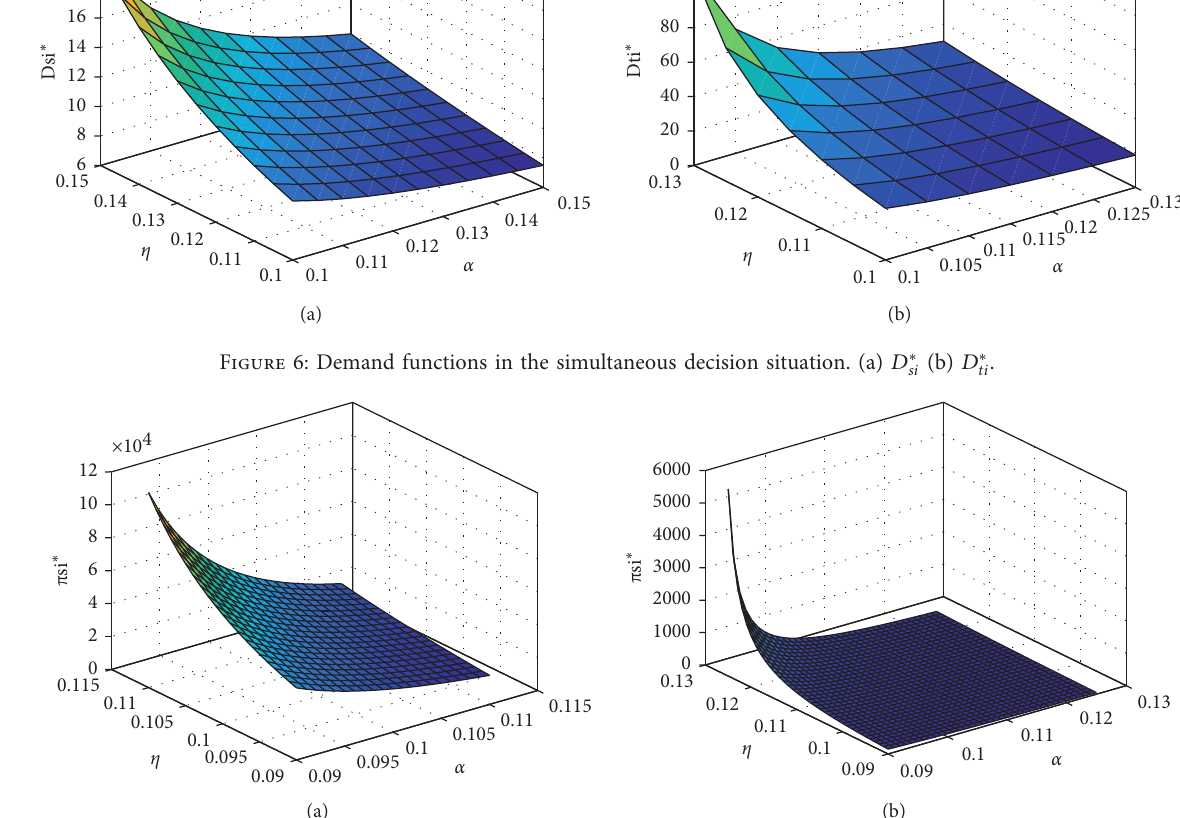
Figure 7: Profits in the simultaneous decision situation. (a) Π